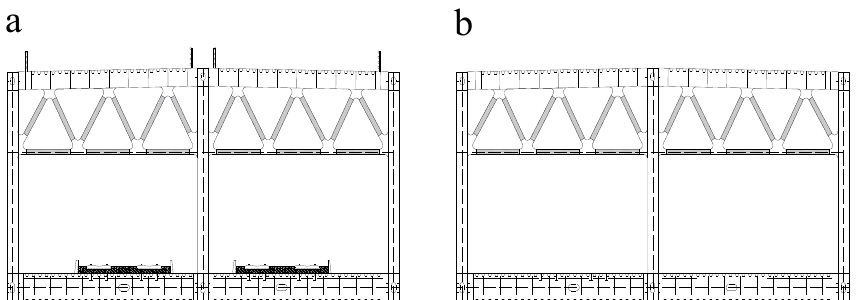
Figure 3. Cross section of the segment model for the service and construction stages: ( a ) for the service stage; ( b ) for the construction stage.